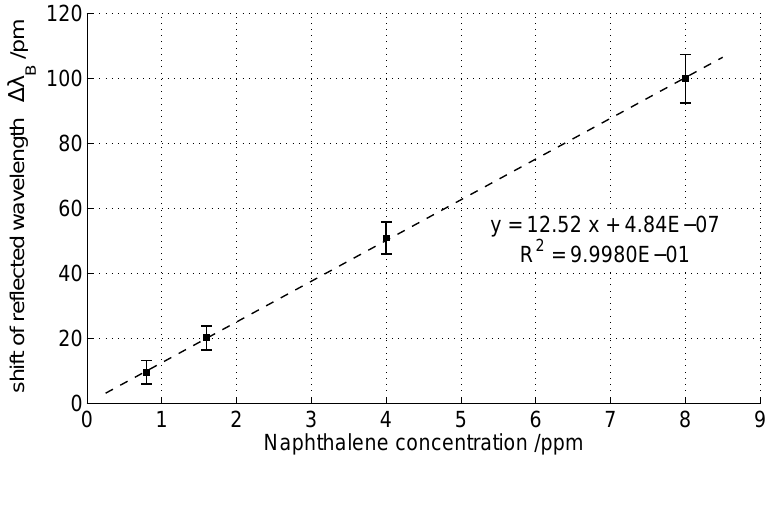
Figure 4. Relationship between the response intensity (average value of the converging signal) and the naphthalene concentration. The error bars take account of the standard deviation of the converging